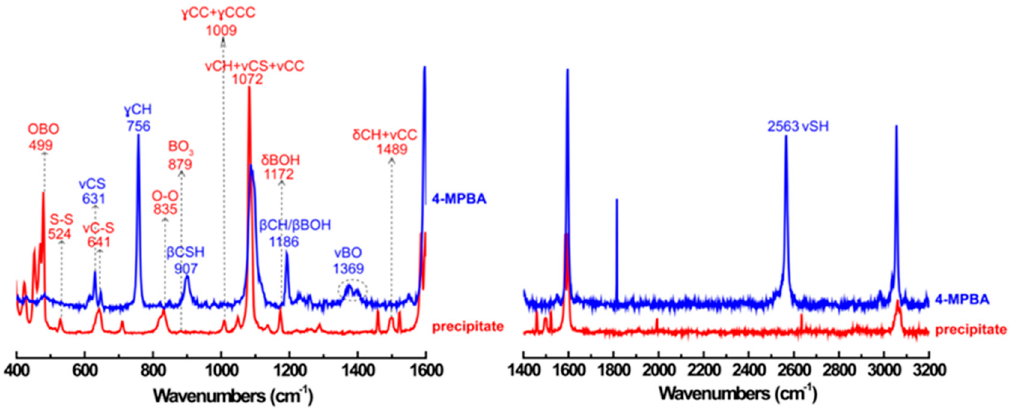
Figure 10. The Raman spectrum of white precipitate formed during the reaction of 4-MPBA (1.87 mM) and H 2 O 2 (0.08 %).